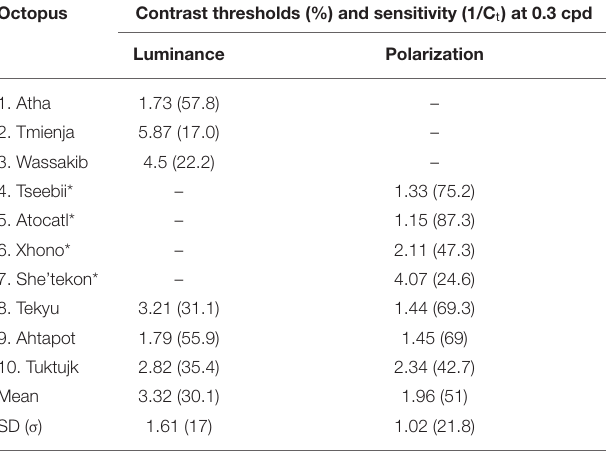
TABLE 1 | Contrast thresholds and sensitivity for luminance and polarization. Octopus Contrast thresholds (%) and sensitivity (1/C t ) at 0.3 cpd Luminance